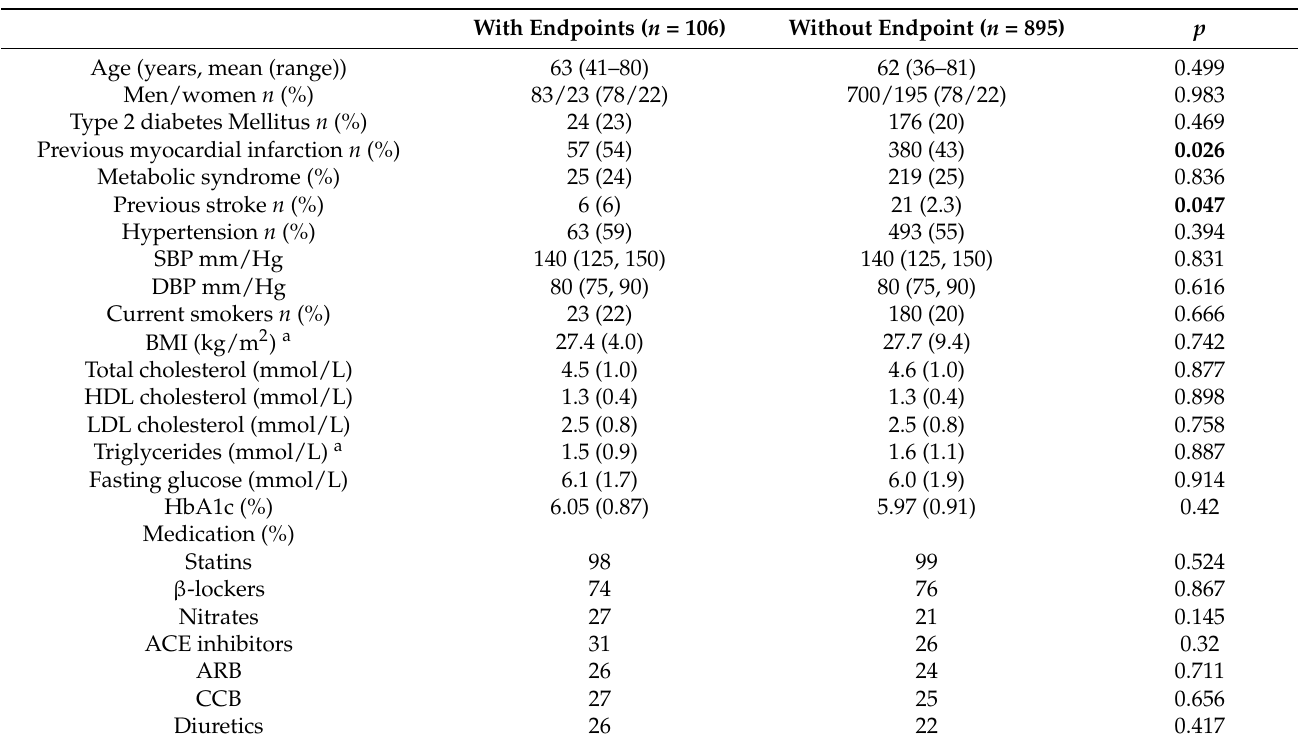
Table 1. Baseline characteristics according to presence of clinical composite endpoints after 2 year in the CAD